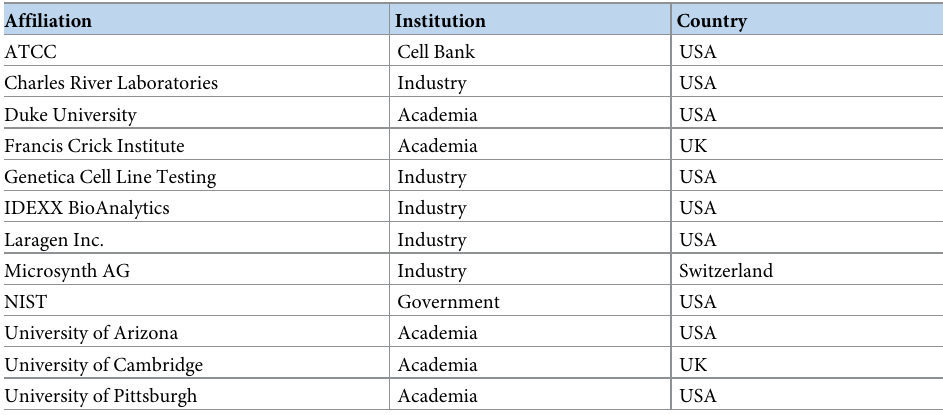
Table 1. Consortium laboratory